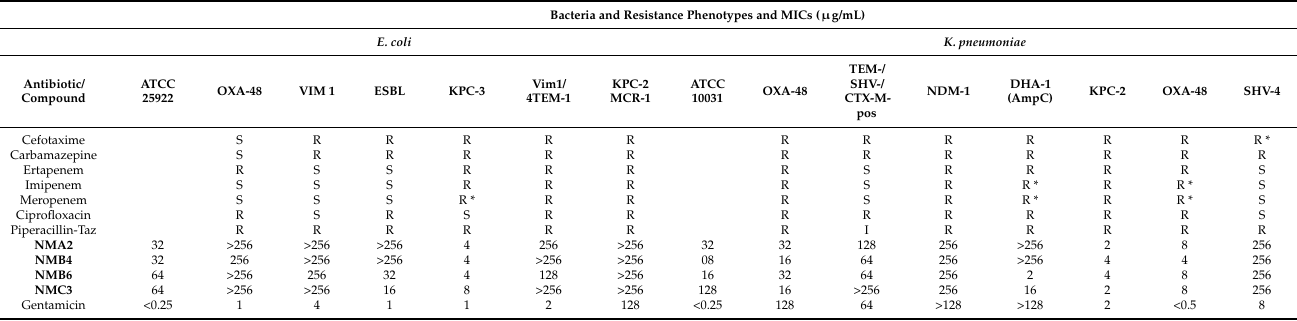
Table 3. MICs of compounds NMA2, NMB4, NMB6, and NMC3 against reference and MDR strains of E. coli and K. Pneumoniae .